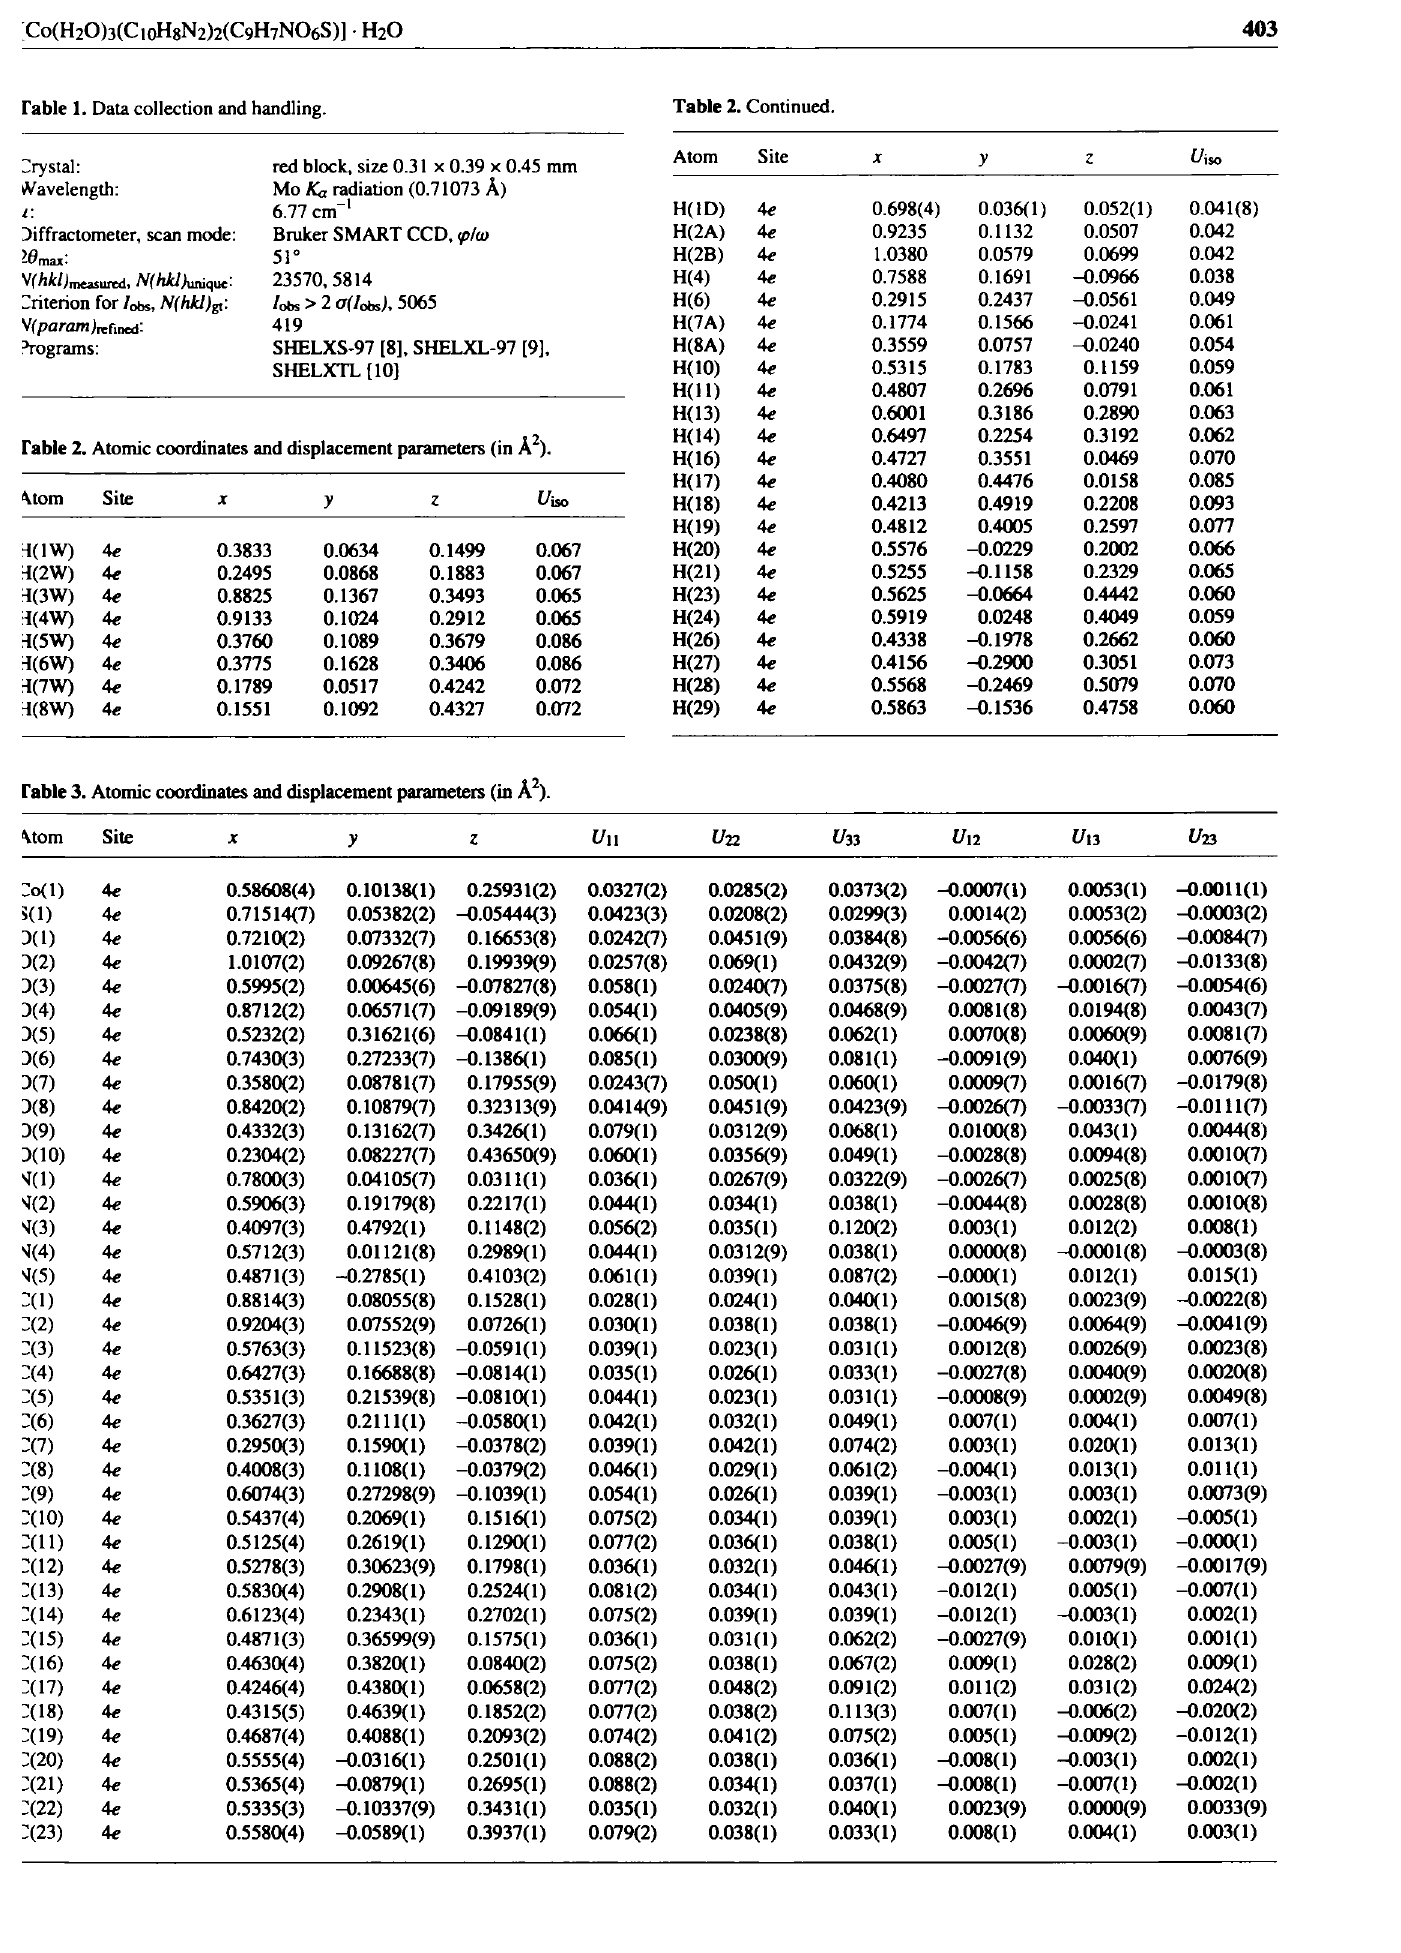
Table 1. Data collection and handling. Table 2. Continued.